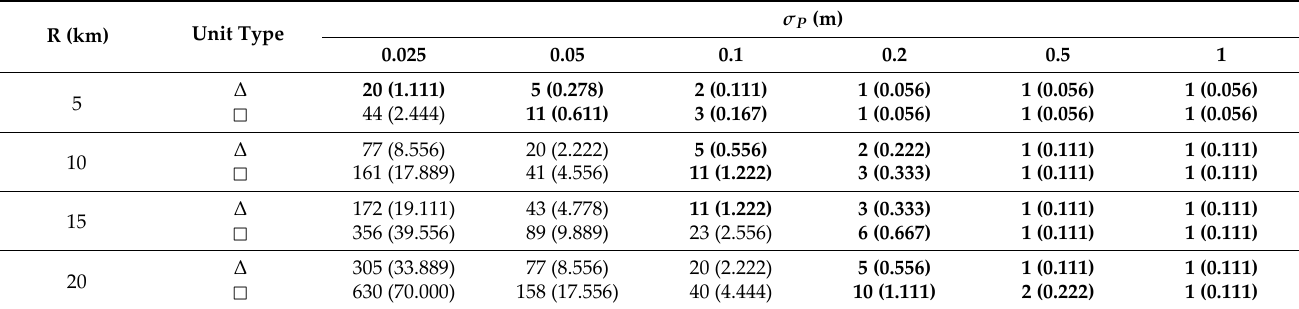
Table 4. The relations among the acoustic ranging capability, R, the number of observation sessions, N, and the total observation time, T.